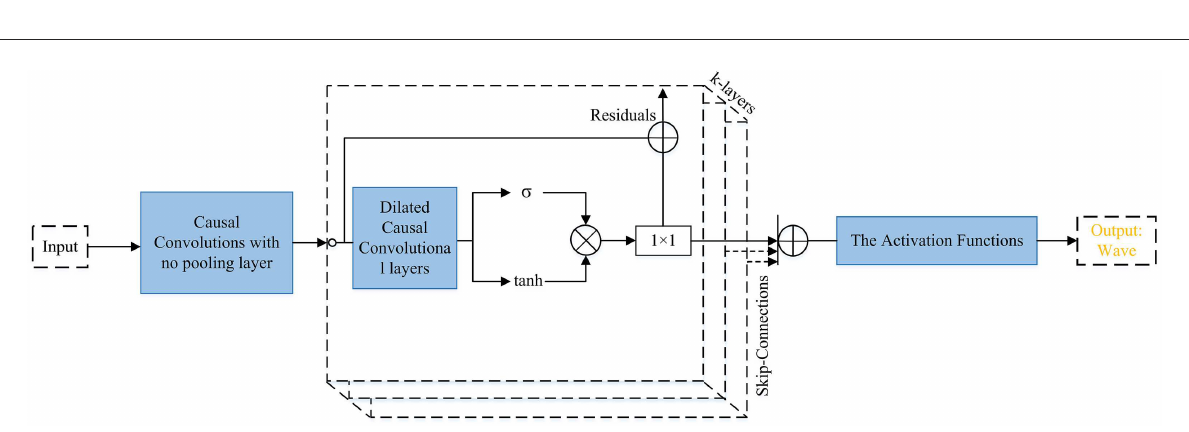
FIGURE5 WaveNet. The input text is presented to causal convolutions, then the output comes to dilated convolutional layers, and then goes to gated activation units, and the activation functions. The Activation Function box includes two (Relu activation functions followed by 1 × 1 layers) plus a Softmax activation function. The figure above also shows the residual block used in